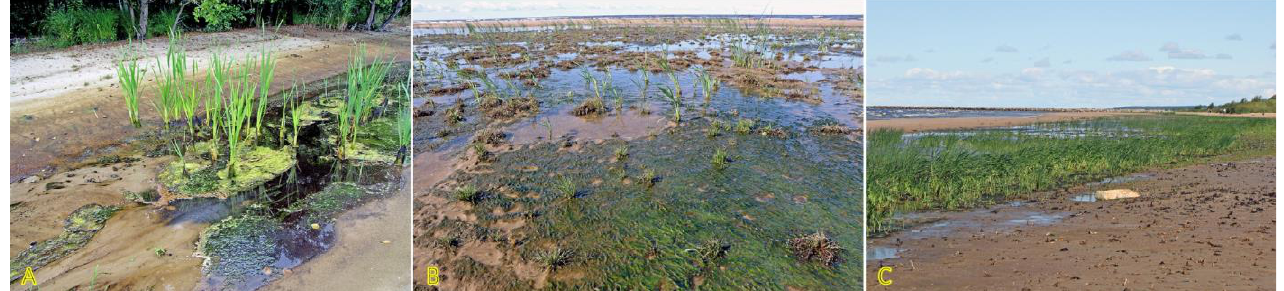
Figure 19. Typha sp. on a wet sandy beach in Melnsils, Latvia ( A ), on a wet sandy beach with developing perennial vegetation in Ainaži, Latvia ( B ), on a permanent coastal lagoon on a wet sandy beach in Salacgrīva, Latvia ( C ).